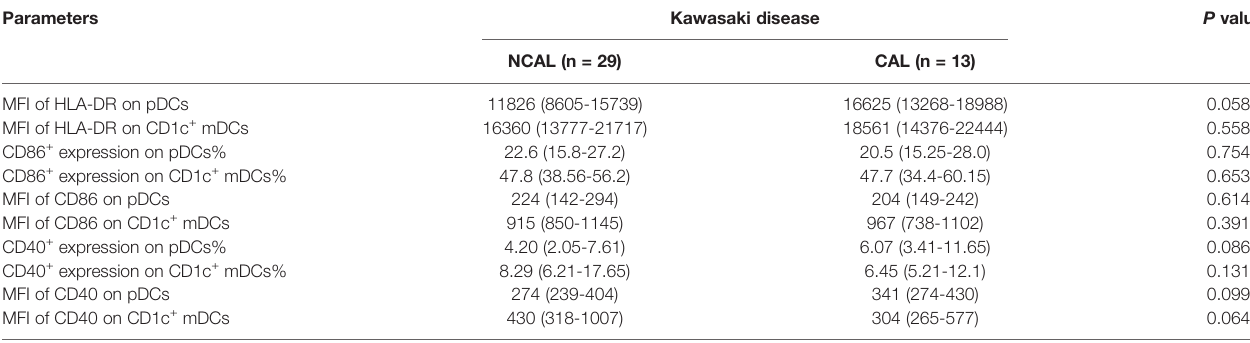
TABLE 4 | HLA-DR, CD86 and CD40 expression on DC subsets between KD patients with and without CAL. Parameters